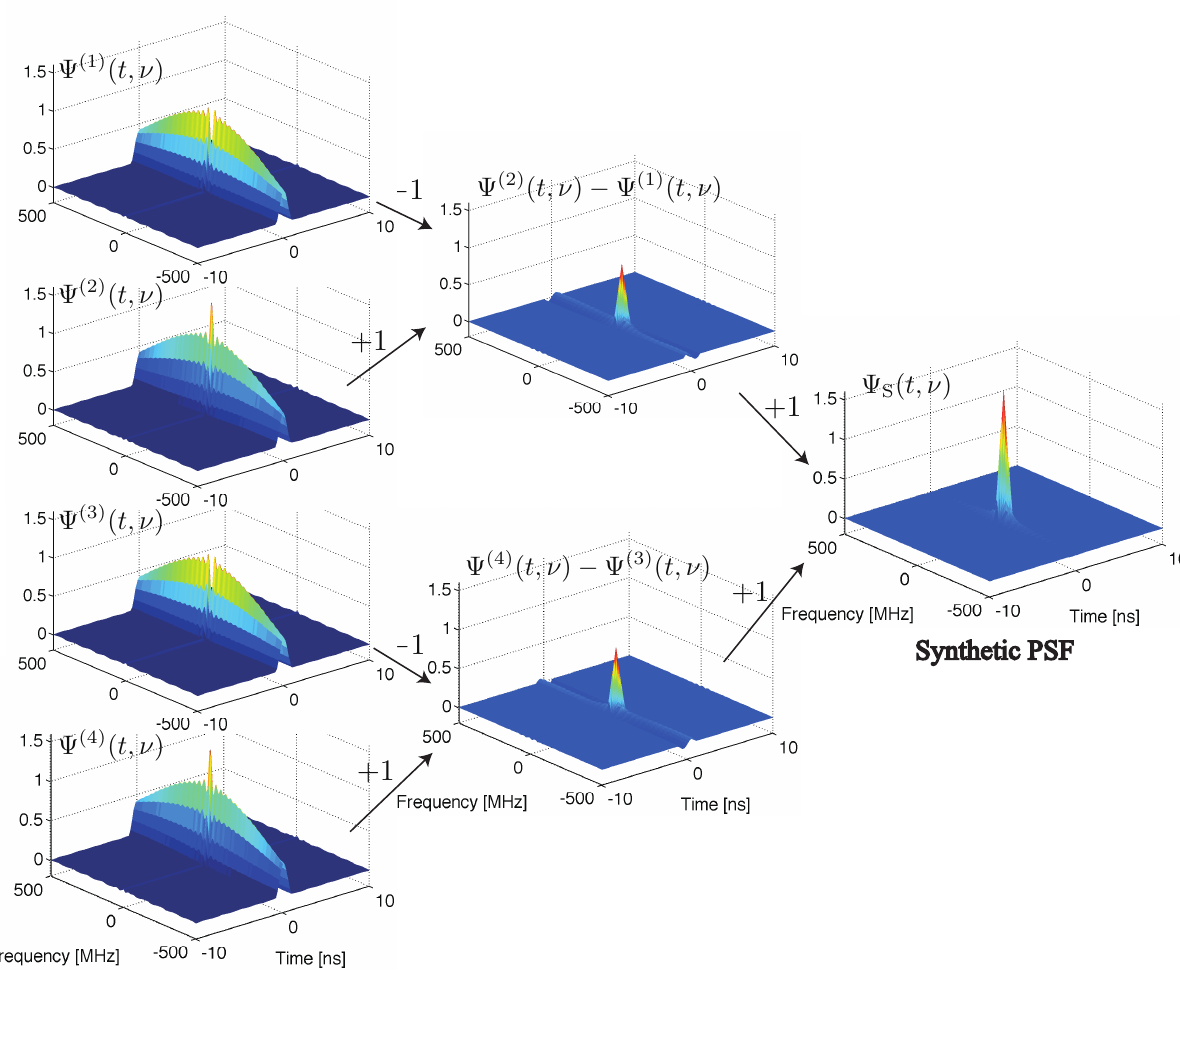
Figure 5. Composition of the synthetic point spread function of S-BOTDR.